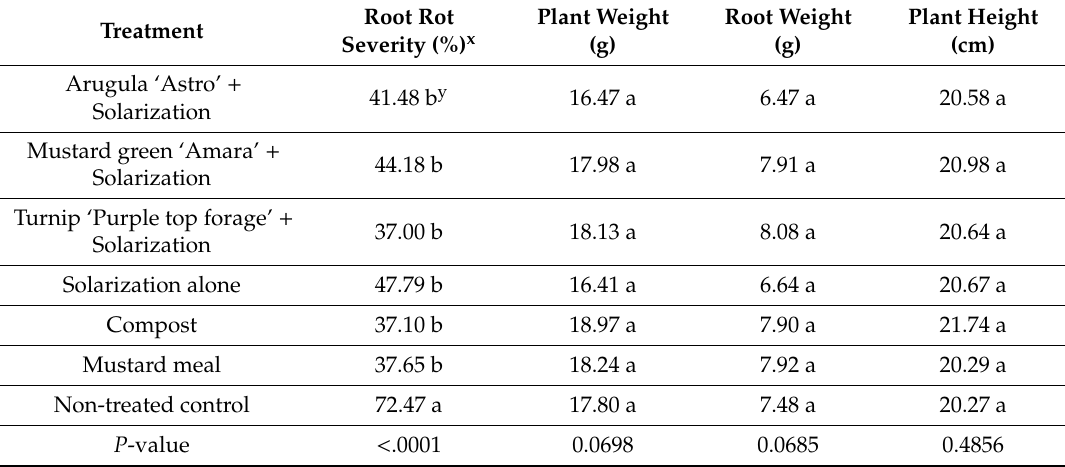
x Disease severity was based on percentage of roots affected. y Values are the means of three replicates; treatments followed by the same letter within a column are not significantly different at P ≤ 0.05.